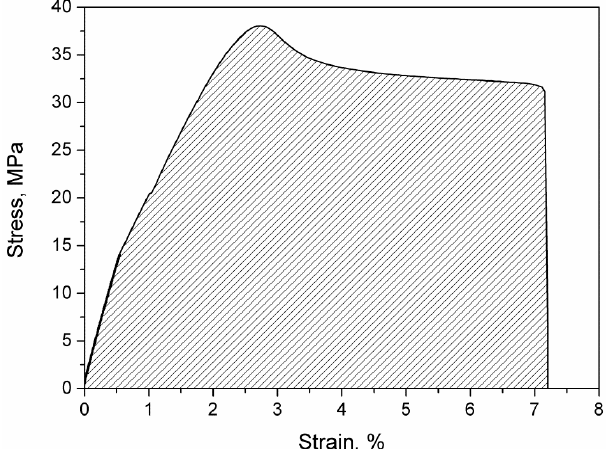
Figure 4. Exemplary stress–strain curve for the 1W45 sample.